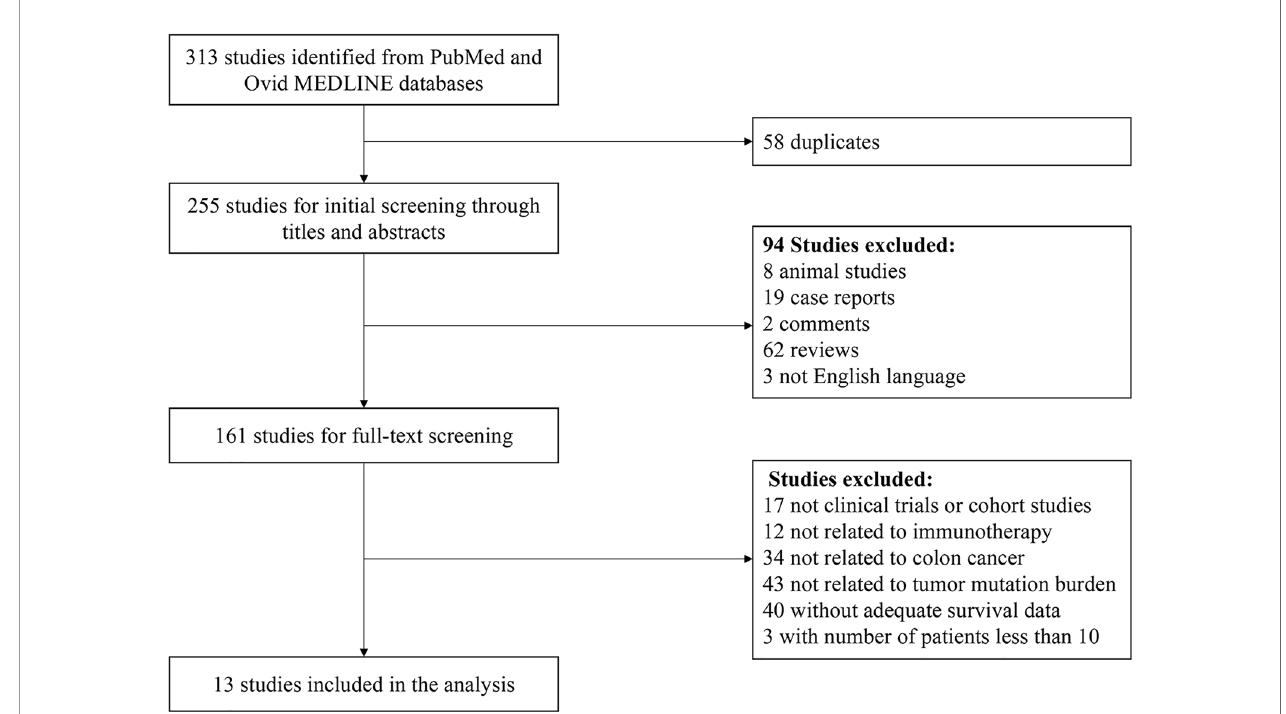
FIGURE 1 | The PRISMA fl